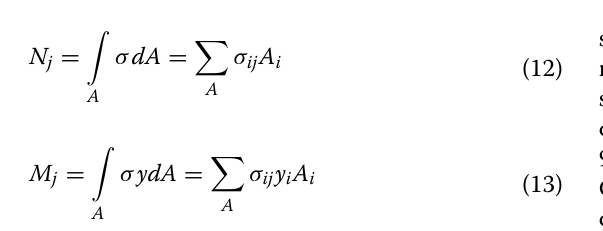
Fig. 13 The changing characteristics of strain-based stressing state modes: a the strain-based stressing state mode of CFRP-strengthened beam B2; b the strain-based stressing state mode of CFRP-strengthened beam B3; c the strain-based stressing state mode of CFRP-strengthened beam